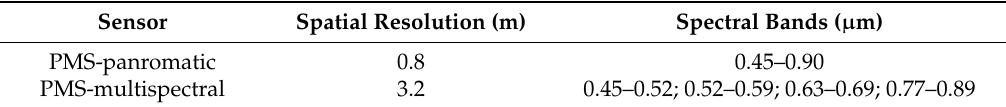
Table 1. Configuration of PMS.